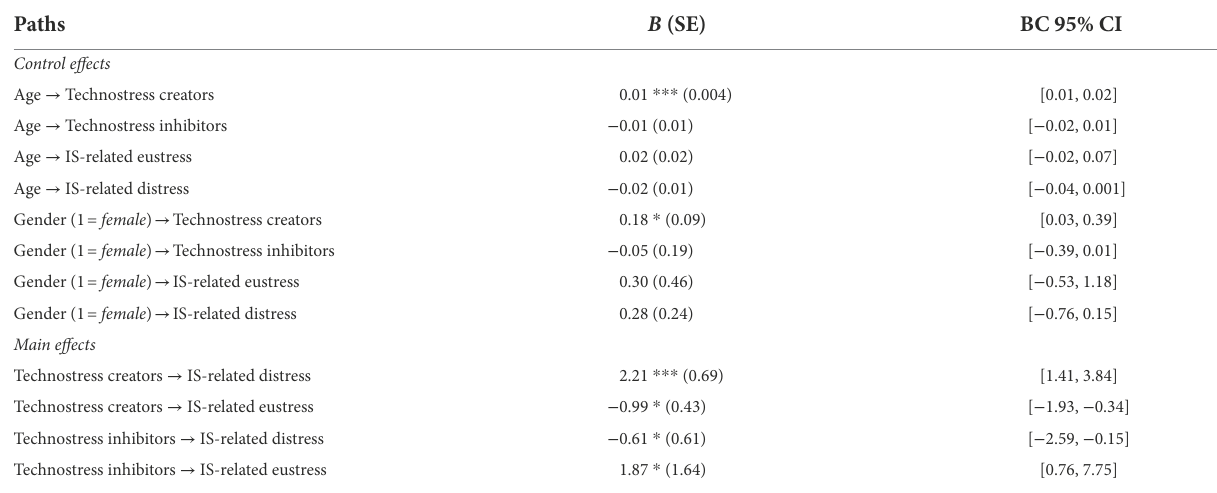
TABLE 2 Model results.